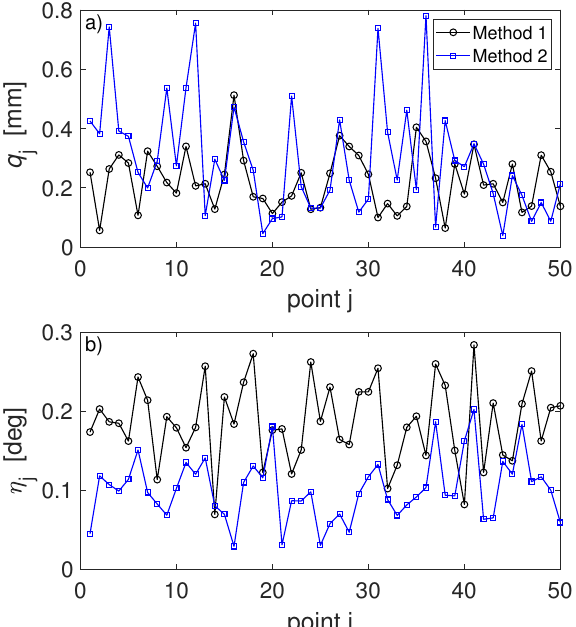
Figure 2. Robot end-effector errors calculated at J = 50 test poses for fixed sensor noise σ p = 0.055 mm, σ a = 0.055 ◦ and one, arbitrary selected noise realization: ( a ) positional errors q j ; ( b ) orientation errors η j . Robot was calibrated with Method 1 (black lines) and Method 2 (blue